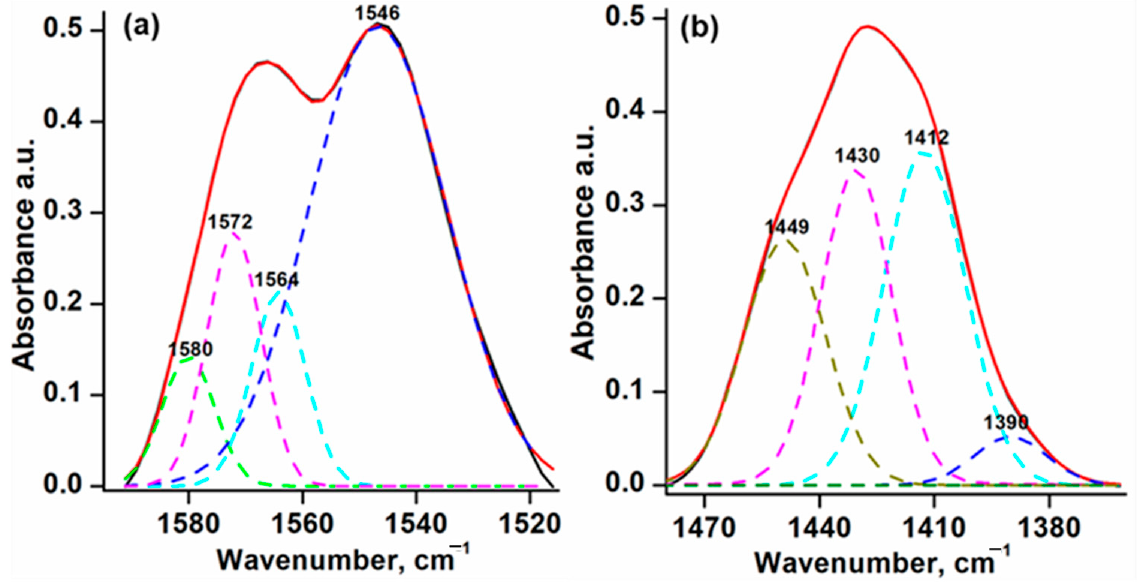
Figure 1. The deconvoluted IR spectra in the 1515 ‐ 1595 cm ‐ 1 ( a ) and 1360 ‐ 1480 cm ‐ 1 ( b ) carboxylate band region of polymer 1.